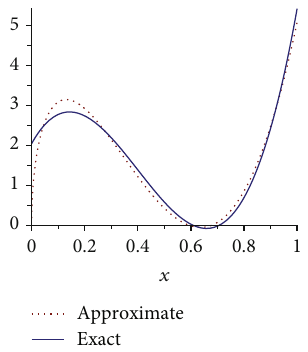
Figure 1: Comparison of the exact solution and approximation for ~ L ð x Þ . 2